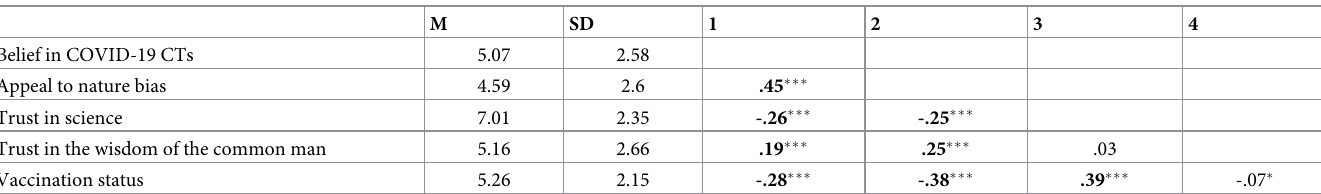
Table 3. Means, standard deviations and Pearson correlations—Study